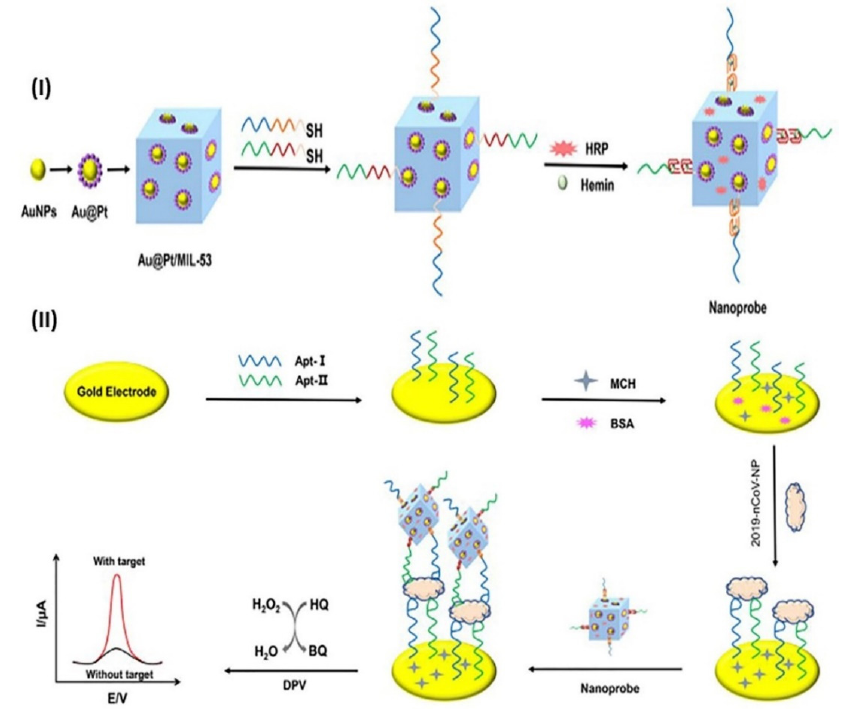
Figure 10. Nucleic acid-based electrochemical biosensors for SARS-CoV-2 detection. Fabrication process of the nanoprobes ( I ) and the aptasensor for capture and detection of SARS-CoV-2 nucleocapsid protein ( II ). Reproduced with permission from [67]. Copyright 2021, Elsevier.